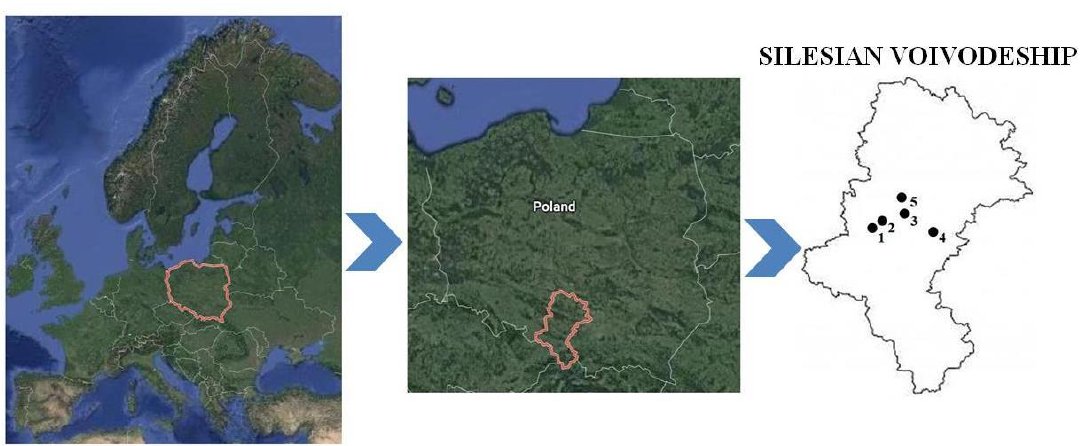
Figure 1. Map of the study area and location of the Wastewater Treatment Plants (WWTPs).